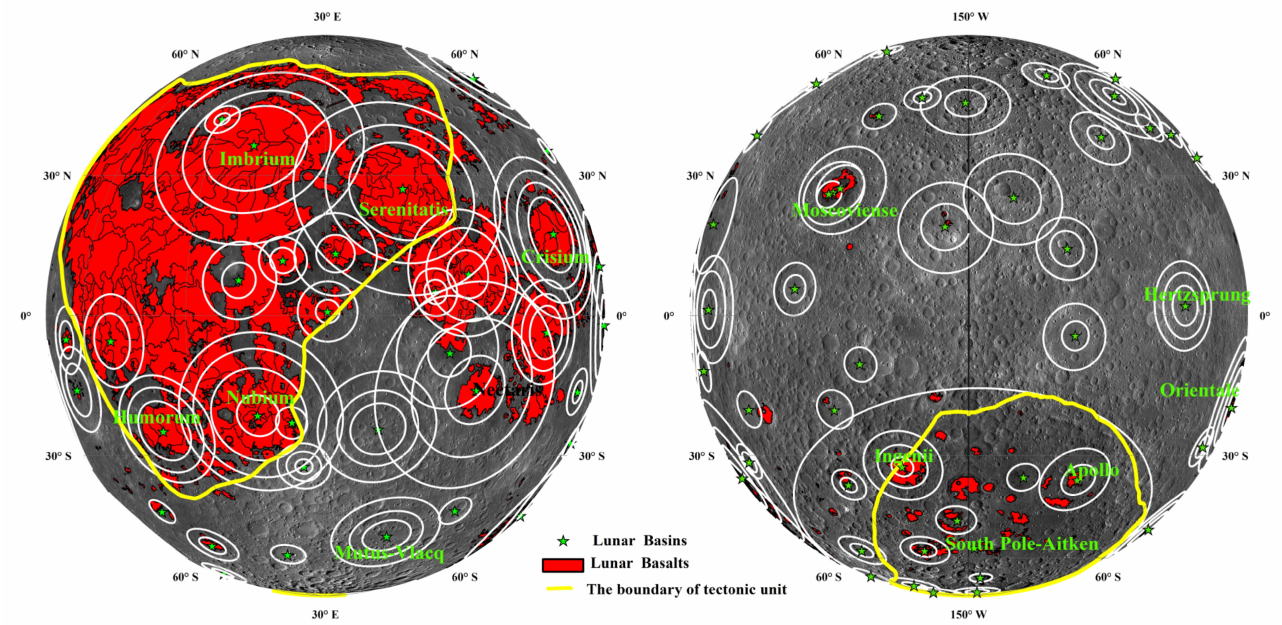
Figure 1. Distribution of the lunar basalts and basins in WAC image (108 m/pix). The boundary of the technical unit based on the work of Jolliff et al., [16], the rings the basins based on the work of Liu et al. [17]; the boundary line of basalt based on the work of Hiesinger et al. [6–9], Morota et al. [10], and Pasckert et al.